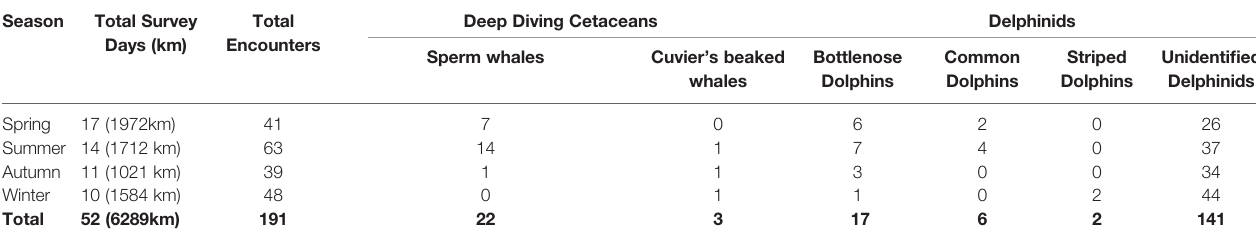
TABLE 1 | Summary of cetacean encounters by